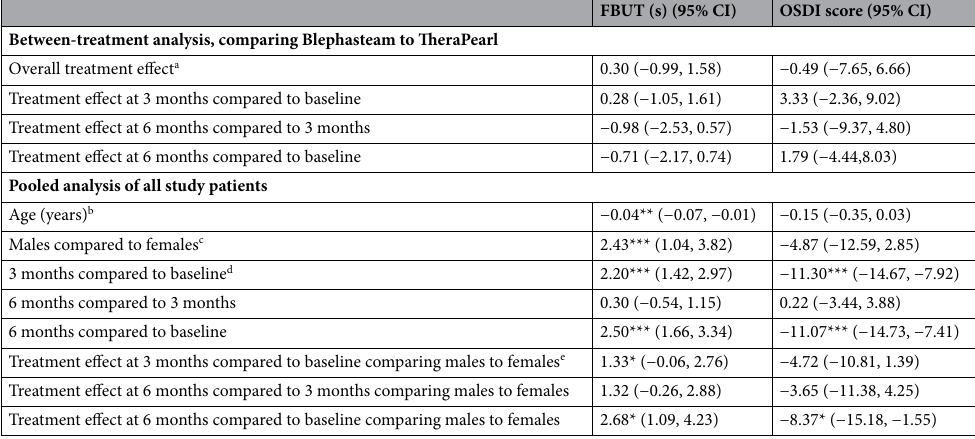
Table 4. Results of the general linear model corrected for age and sex. FBUT was also corrected for interocular differences between the eyes. CI confidence interval, FBUT fluorescein breakup time, OSDI ocular surface